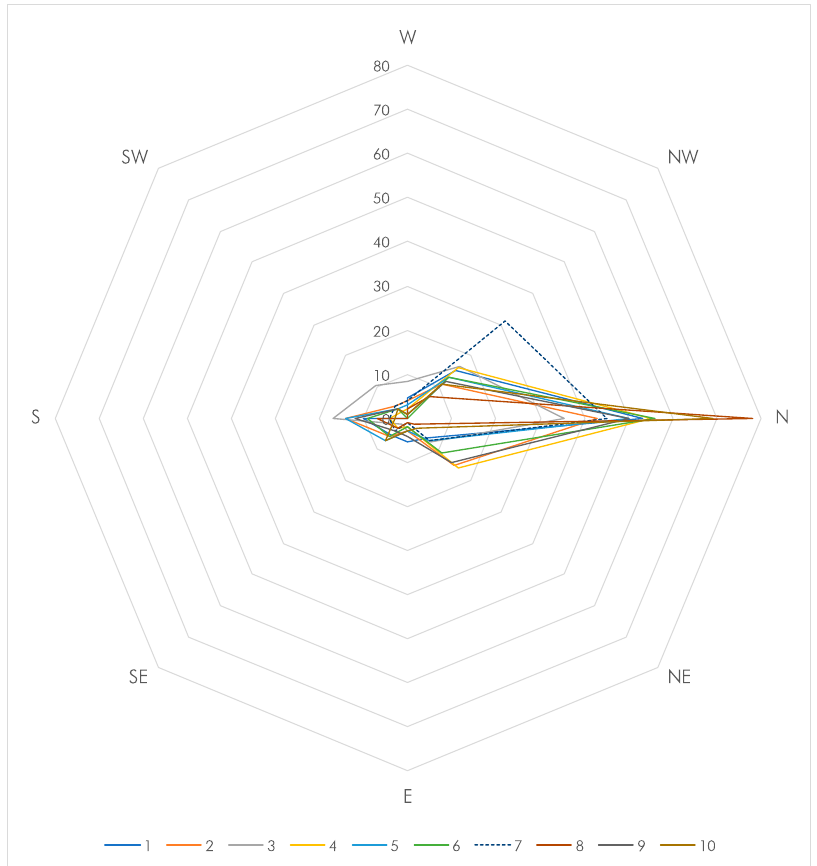
Figure 5. Radar plot showing the final distribution of beetles across the octants (in %). Each color represents the distribution of a replicate (numbered 1–10).